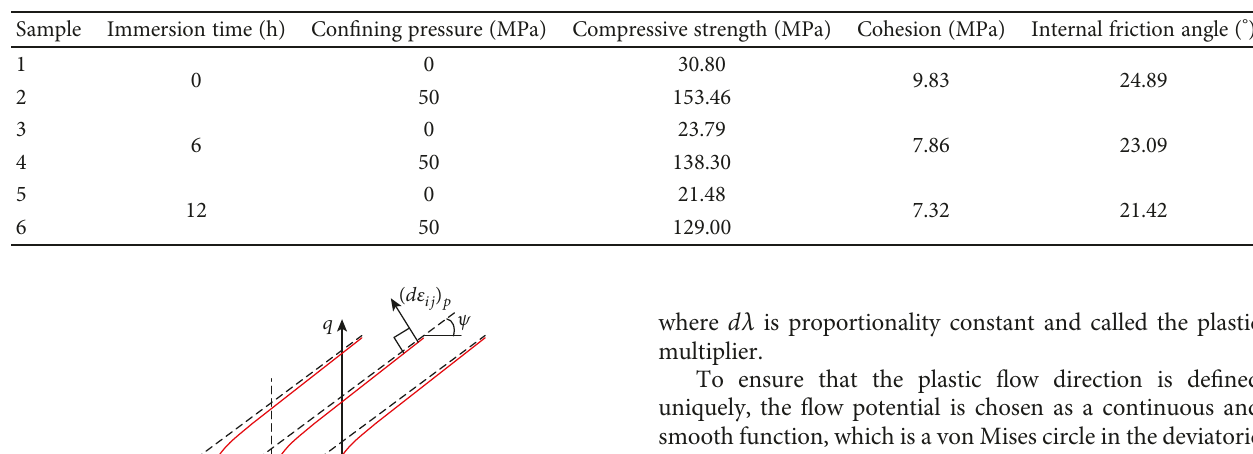
Table 3: Strength changes of shale under drilling fl uid immersion.